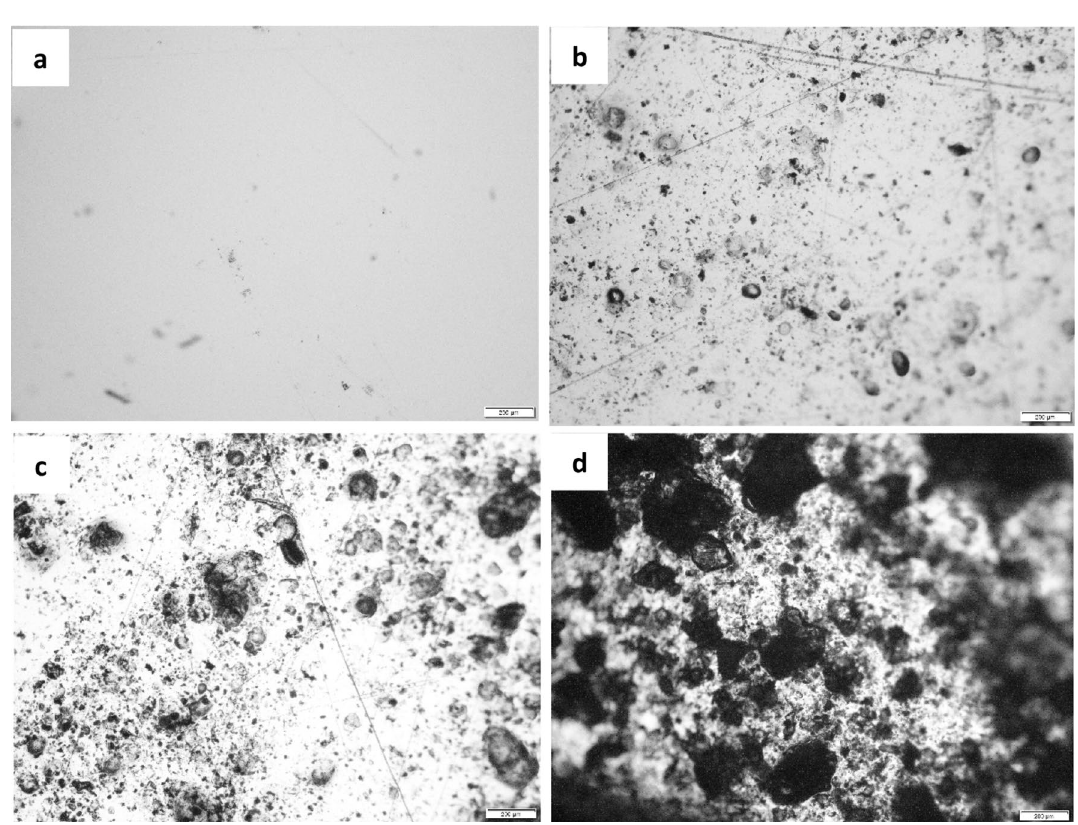
Figure 9. Optical microscopic image of PVA/CMC/TUR films: ( a ) PCT-0 ( b ) PCT-1 ( c ) PCT-2 ( d )